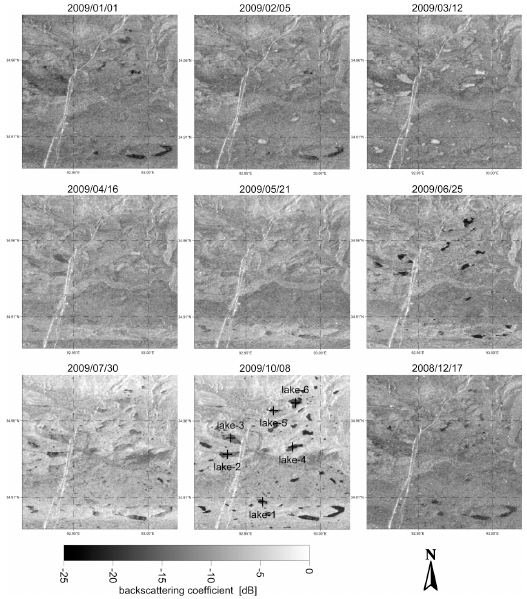
Figure 3. A selection of processed ASAR image